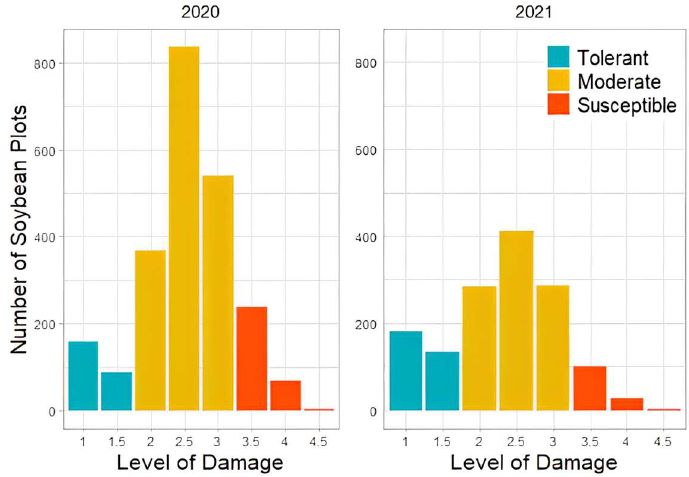
Figure 3. Distribution of off-target dicamba damage scores assessed by breeders in 2020 and 2021. The horizontal axis has the visual scores that were classified into three tolerance classes, i.e., Tolerant (blue), Moderate (yellow), and Susceptible (red).